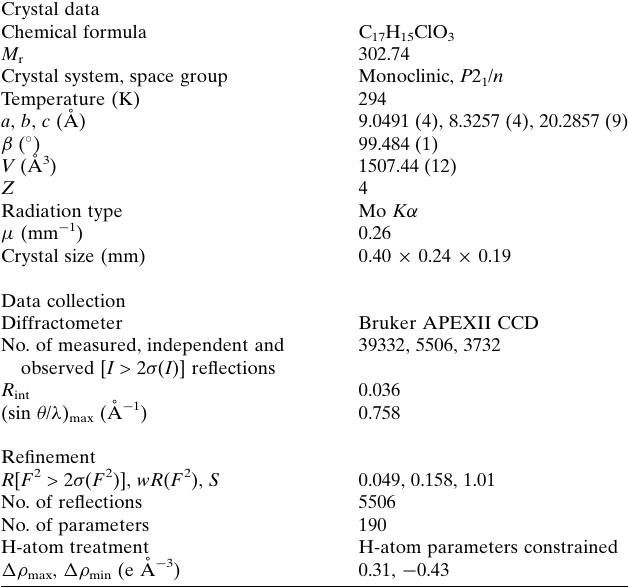
Table 3 Experimental details. Crystal data Chemical